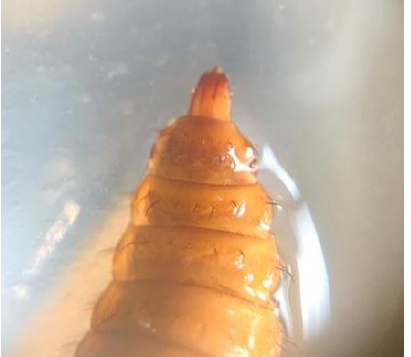
Figure 3: An adult Black soldier fly being held in hand where its white-edged feet and reproductive prominence can be seen.